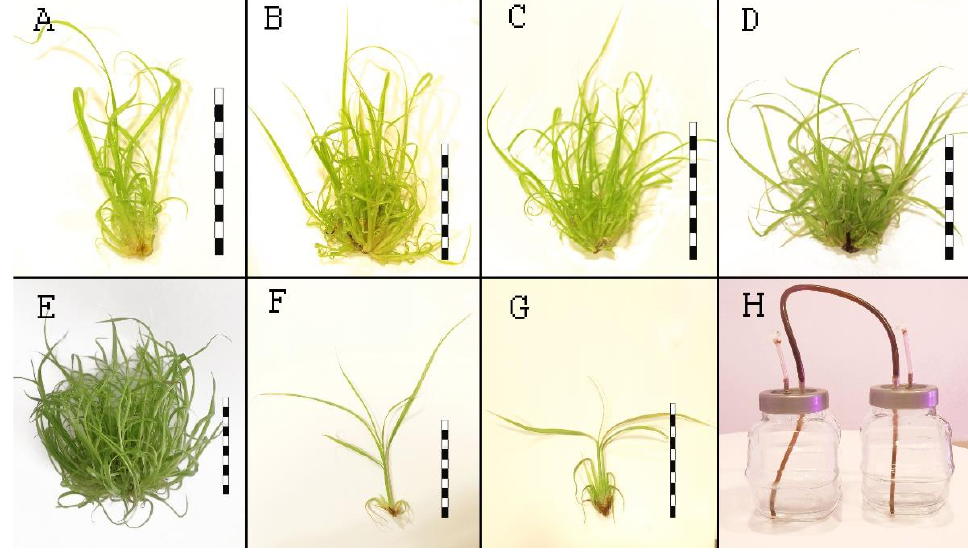
Figure 1. Effect of multiplication media. ( A ). Plants obtained after 8 weeks on M1. ( B ). Plants obtained after 8 weeks on M2. ( C ). Plants obtained after 8 weeks on M3. ( D ). Plants obtained after 8 weeks on M4. ( E ). Plants obtained after 4 weeks on M5 medium. ( F ). Representative single plant from M1, M2, M3, M5. ( G ). Representative single plant from M4. ( H ). Temporary immersion bioreactor system. Bars = 5.0 cm.